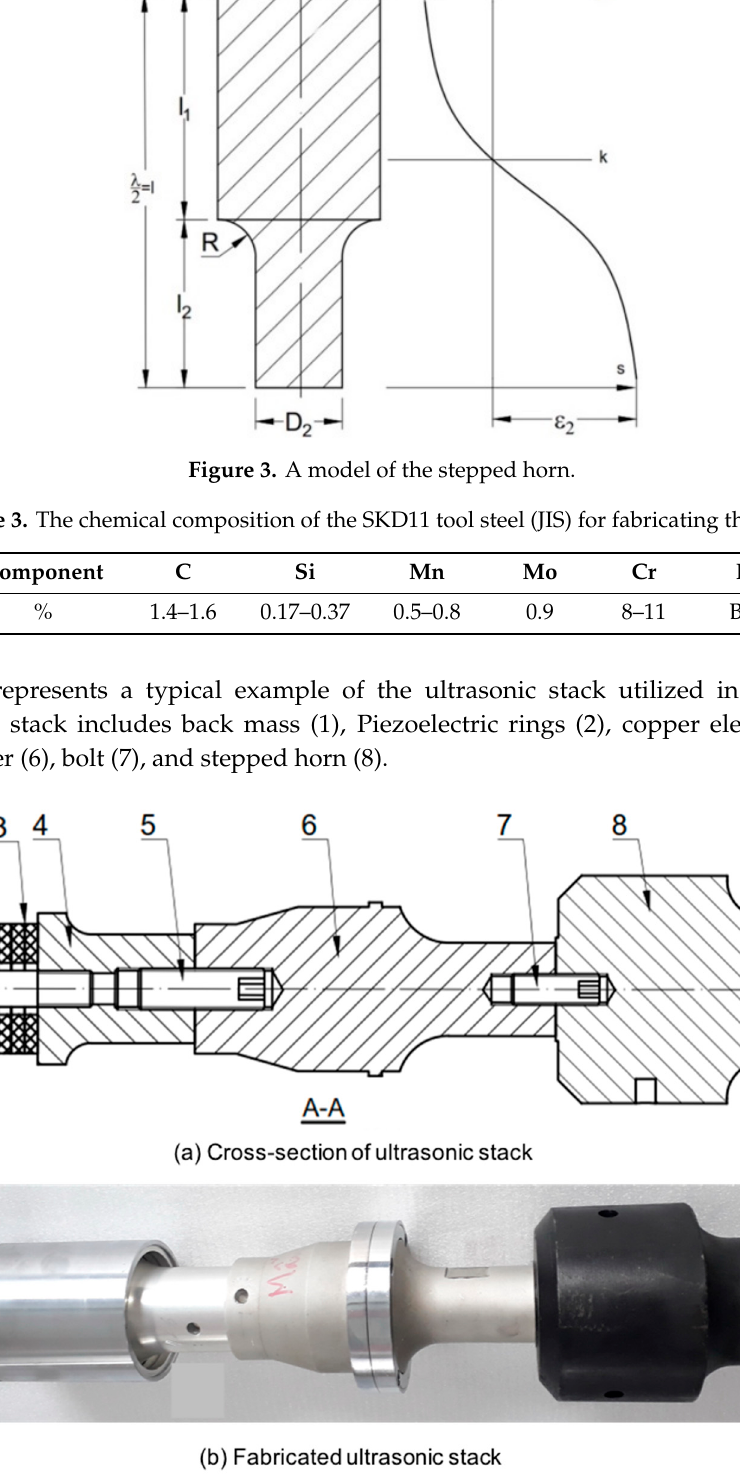
Figure 4. An example of ultrasonic stack. ( a ) Cross-section of ultrasonic stack, ( b ) Fabricated ultrasonic stack.